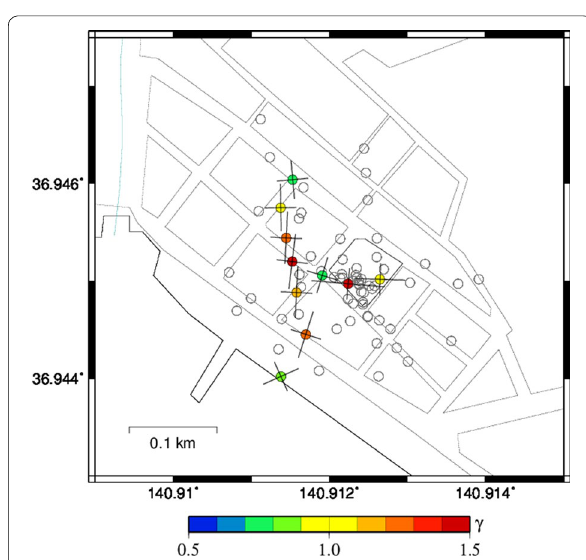
Fig. 11 Largest γ value and axes direction of the largest and smallest amplitude for the corresponding direction. Points for which the larg- est axis is oriented in the NS direction are aligned in the NS direction, and the points where largest axis is oriented in the EW direction are aligned in the EW direction, forming a T-shaped distribution